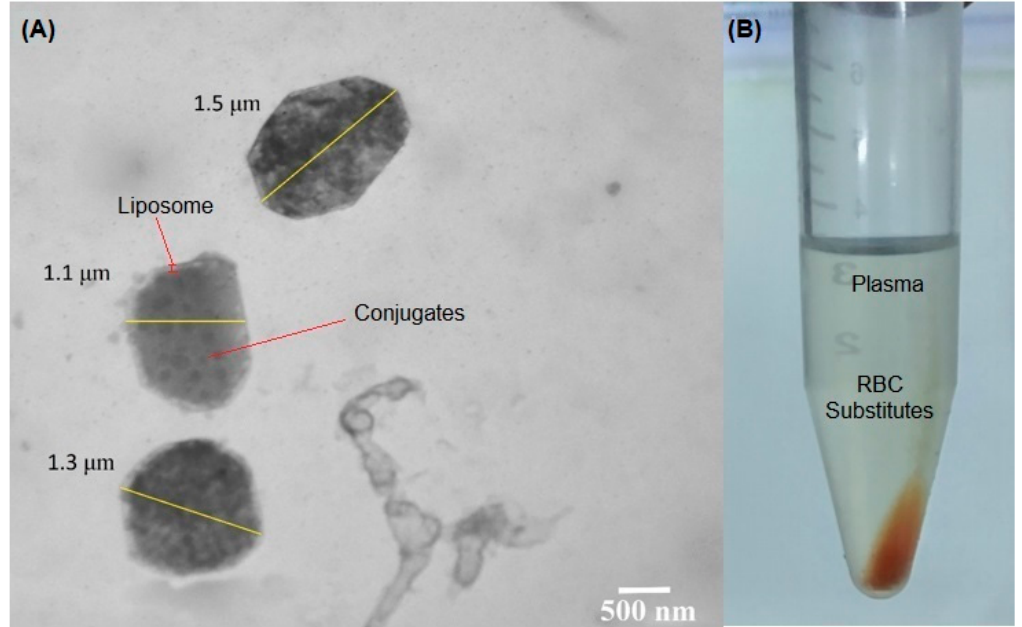
Figure 8. ( A ) TEM image of RBC substitutes. The coat represents liposome, the core represents the conjugates of magnetite and hemoglobin, ( B ) Pellet of RBC substitutes in blood